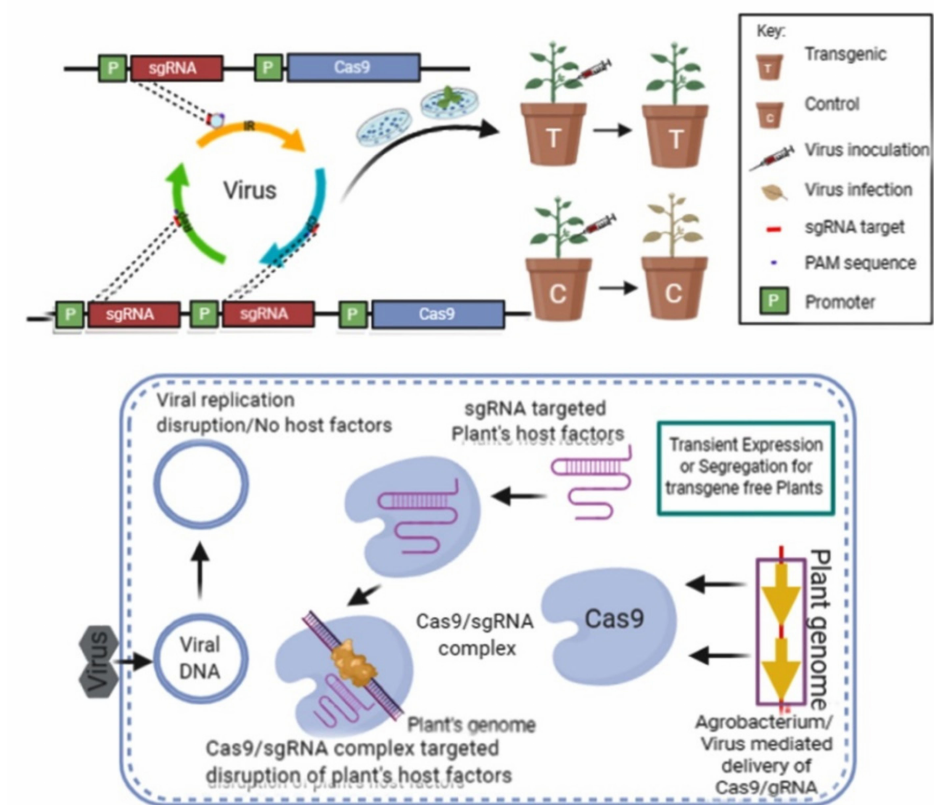
Figure 1. Virus resistance via CRISPR/Cas9 (illustration is adapted and modified from Zaidi et al. [14]).